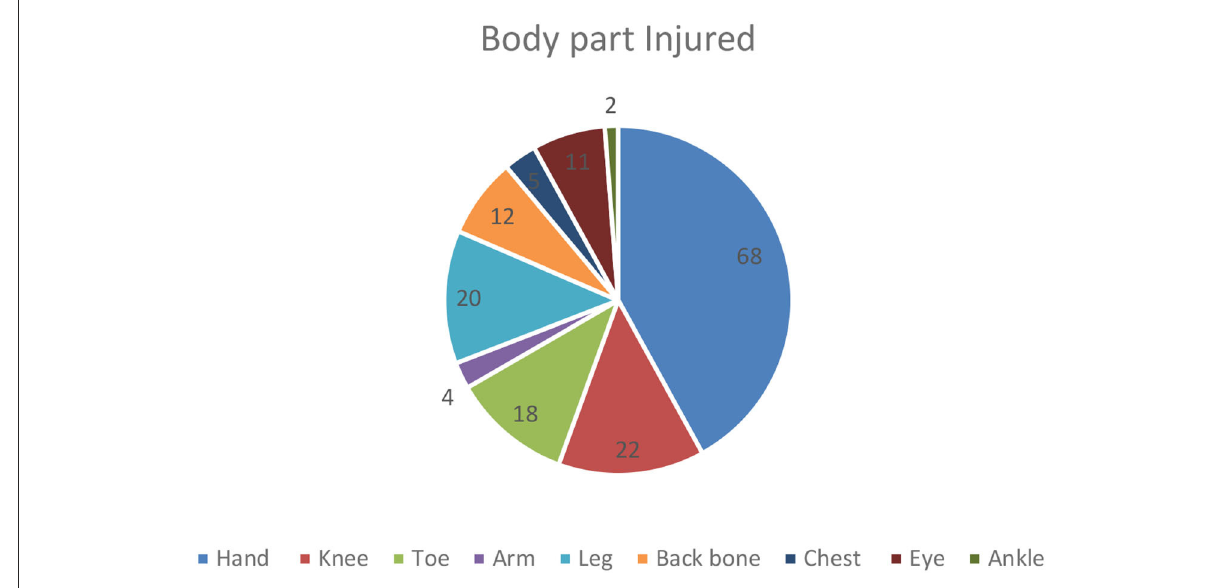
FIGURE3 Body part injured among coffee industry workers, Bench-Sheko and Kafa zones, May/2021.